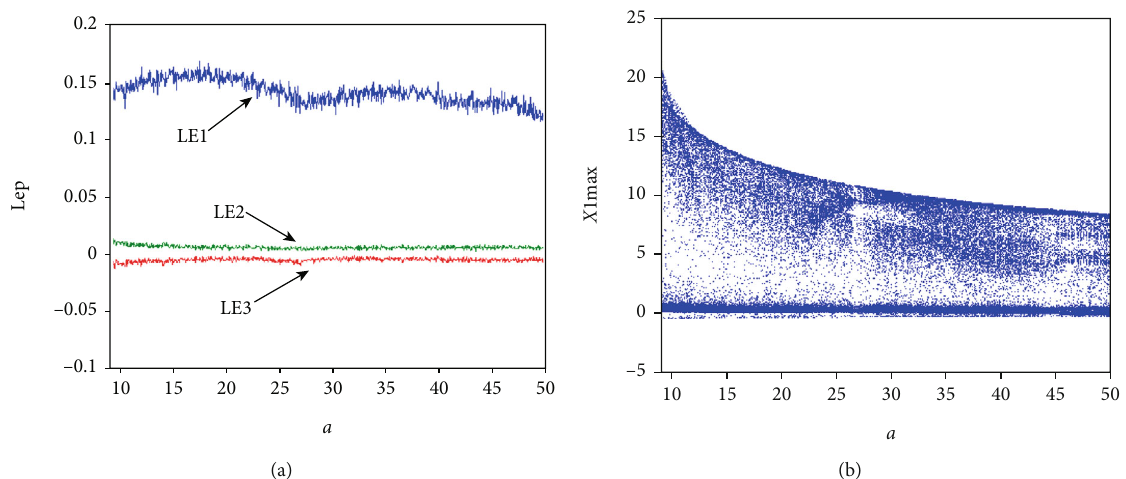
Figure 4: Lyapunov exponent spectrum and bifurcation diagram with respect to a : (a) Lyapunov exponent spectrum and (b) bifurcation diagram.